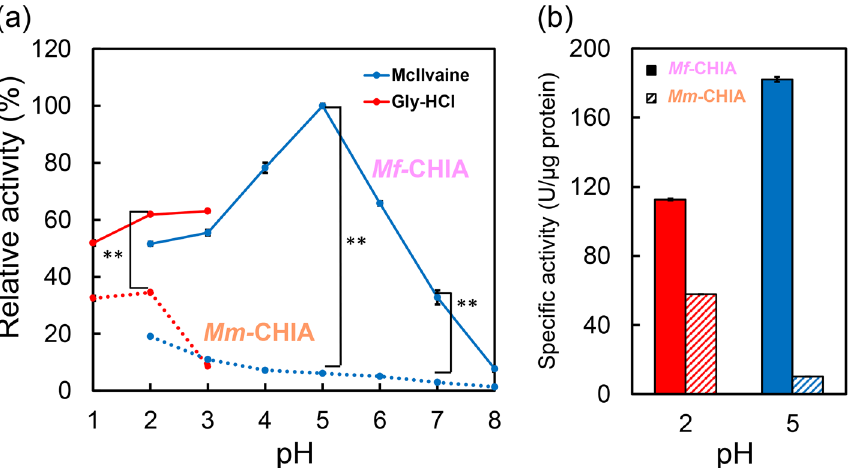
Figure 2. Optimal pH for Mf -CHIA and comparison with Mm -CHIA. The chitinolytic activity of Mf -CHIA and Mm -CHIA was measured using 4-NP-(GlcNAc) 2 . ( a ) Solid lines, Mf -CHIA; dotted lines, Mm -CHIA. The chitinase activity was analyzed in Gly-HCl buffer (pH 1.0 to 3.0) or McIlvaine’s buffer (pH 2.0 to 8.0) at 37 °C for 60 min. Red lines, Gly-HCl buffer; blue lines, McIlvaine’s buffer. We show relative activity when the Mf -CHIA activity level at pH 5.0 was set to 100%. ( b ) Showing specific enzymatic activity, we compared Mf -CHIA with Mm -CHIA at their respective optimal pH ( Mf -CHIA at pH 5.0, Mm -CHIA at pH 2.0). Filled bars, Mf -CHIA; hatched bars, Mm -CHIA. The chitinolytic activities are expressed with the subtraction of the blank experiments. Error bars represent mean ± standard deviation from a single experiment conducted in triplicate. ** p <